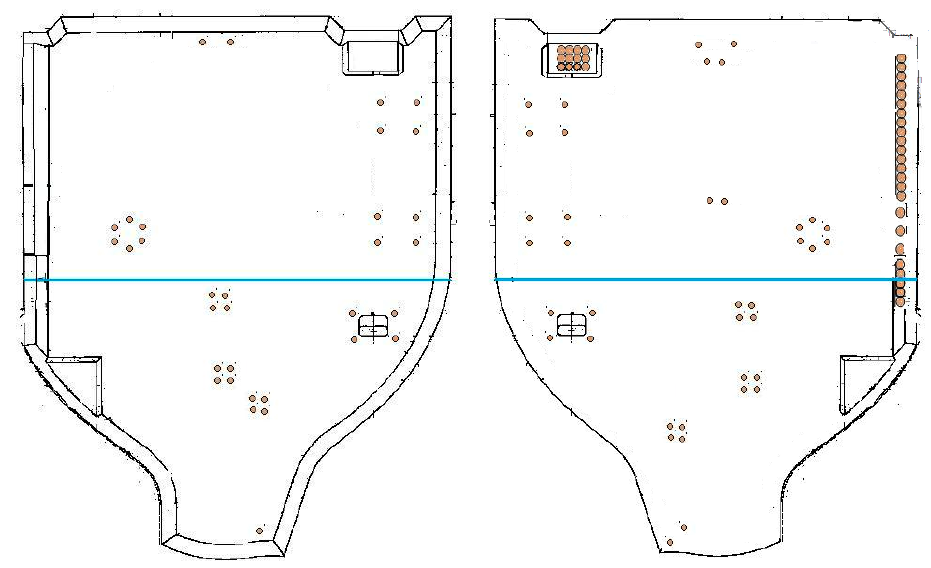
Figure 1. Drawing of the main landing-gear door of the Airbus A320 model: internal ( left ) and external ( right ) door faces. The overall size is about 1750 mm × 1680 mm. The positions of the 107 pocket milling operations (39 mm diameter) are marked as colour spots.